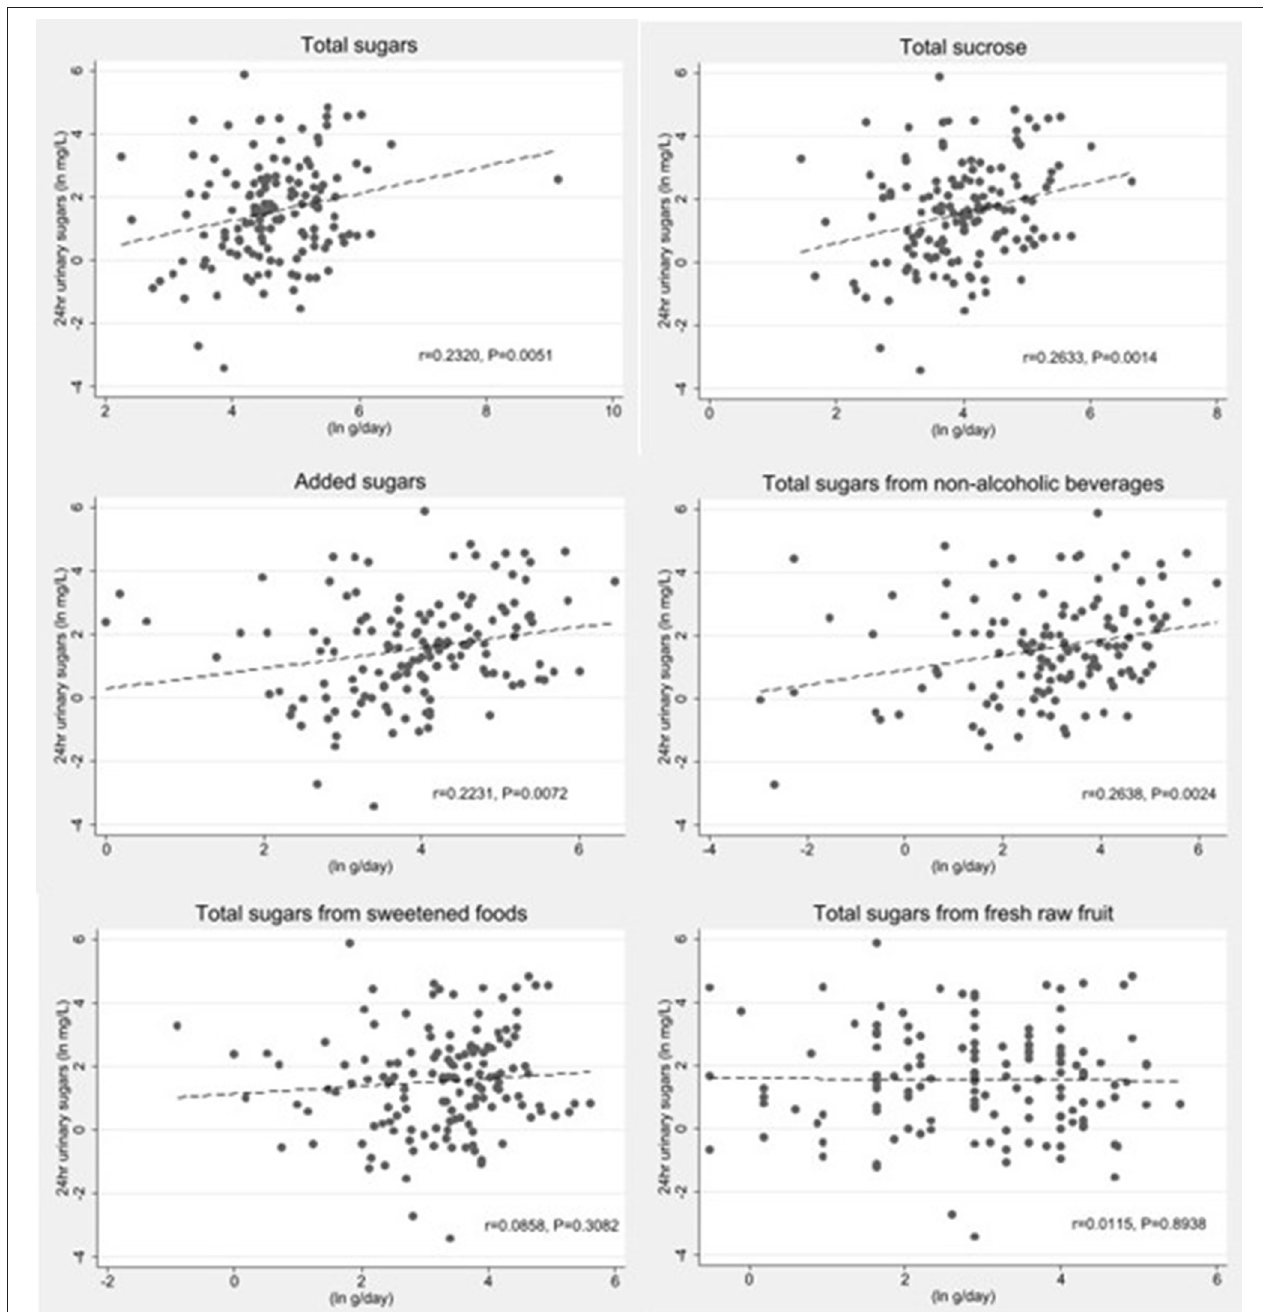
FIGURE 1 | Scatter plots of log transformed estimated 24h urinary sucrose + fructose excretion by log transformed sugars intakes estimated by a sugar specific FFQ ( n = 140). The dashes lines represent the linear fit models.